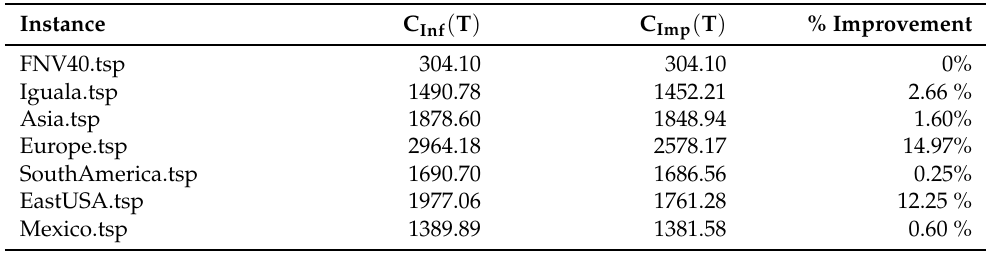
Table 5. A summary of the improvements accomplished at the last improvement stage of the inflammation